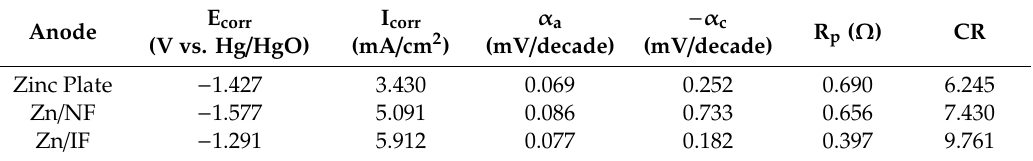
Table 2. Corrosion parameters of metals in solution